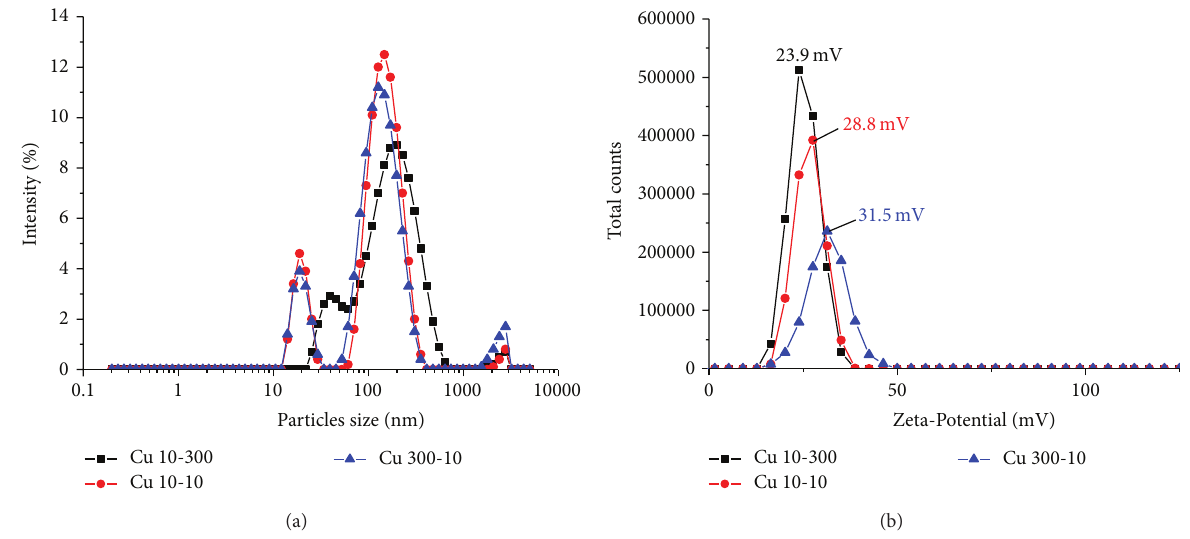
Figure 7: Nanocopper fluid. (a) Particles size analysis; (b) Zeta-Potential analysis.